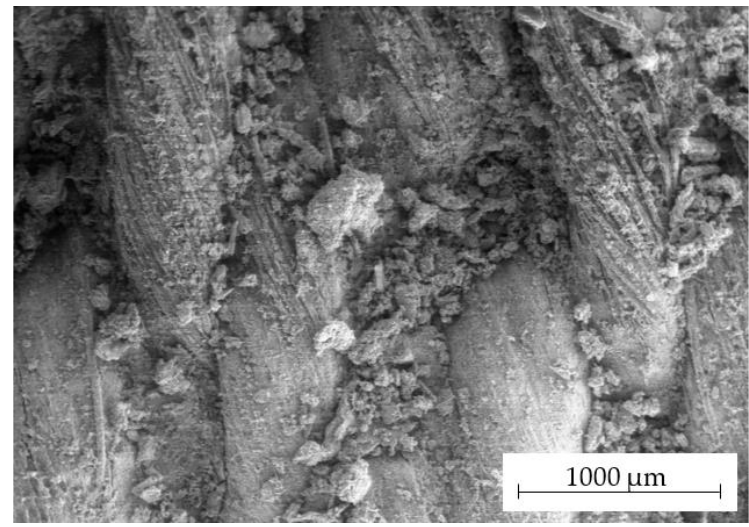
Figure 1. SEM image (85×) of the industrial used (blinded) iron ore tailings filter cloth surface showing the blocked particles between and within the fibers.